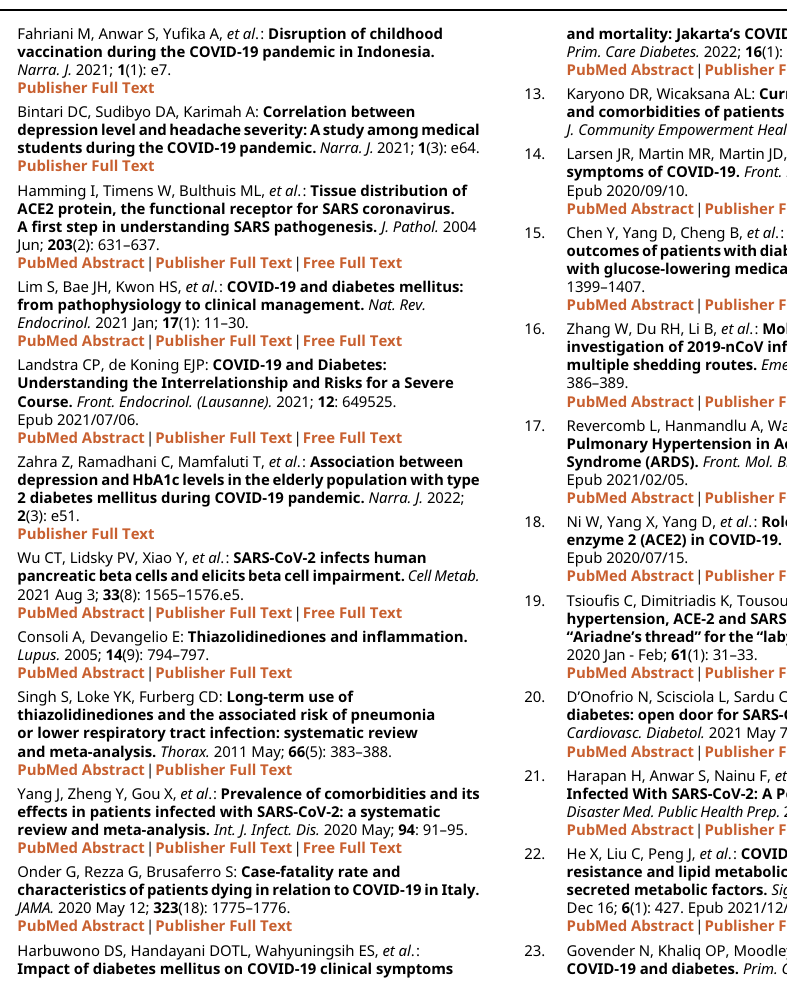
Figshare: STROBE checklist for “ Clinical characteristics and outcomes of hospitalized COVID-19 patients with diabetes mellitus in East Java, Indonesia: A cross-sectional study ” - https://doi.org/10.6084/m9.figshare.19388975. All data are available under the terms of the Creative Commons Attribution 4.0 International license (CC-BY